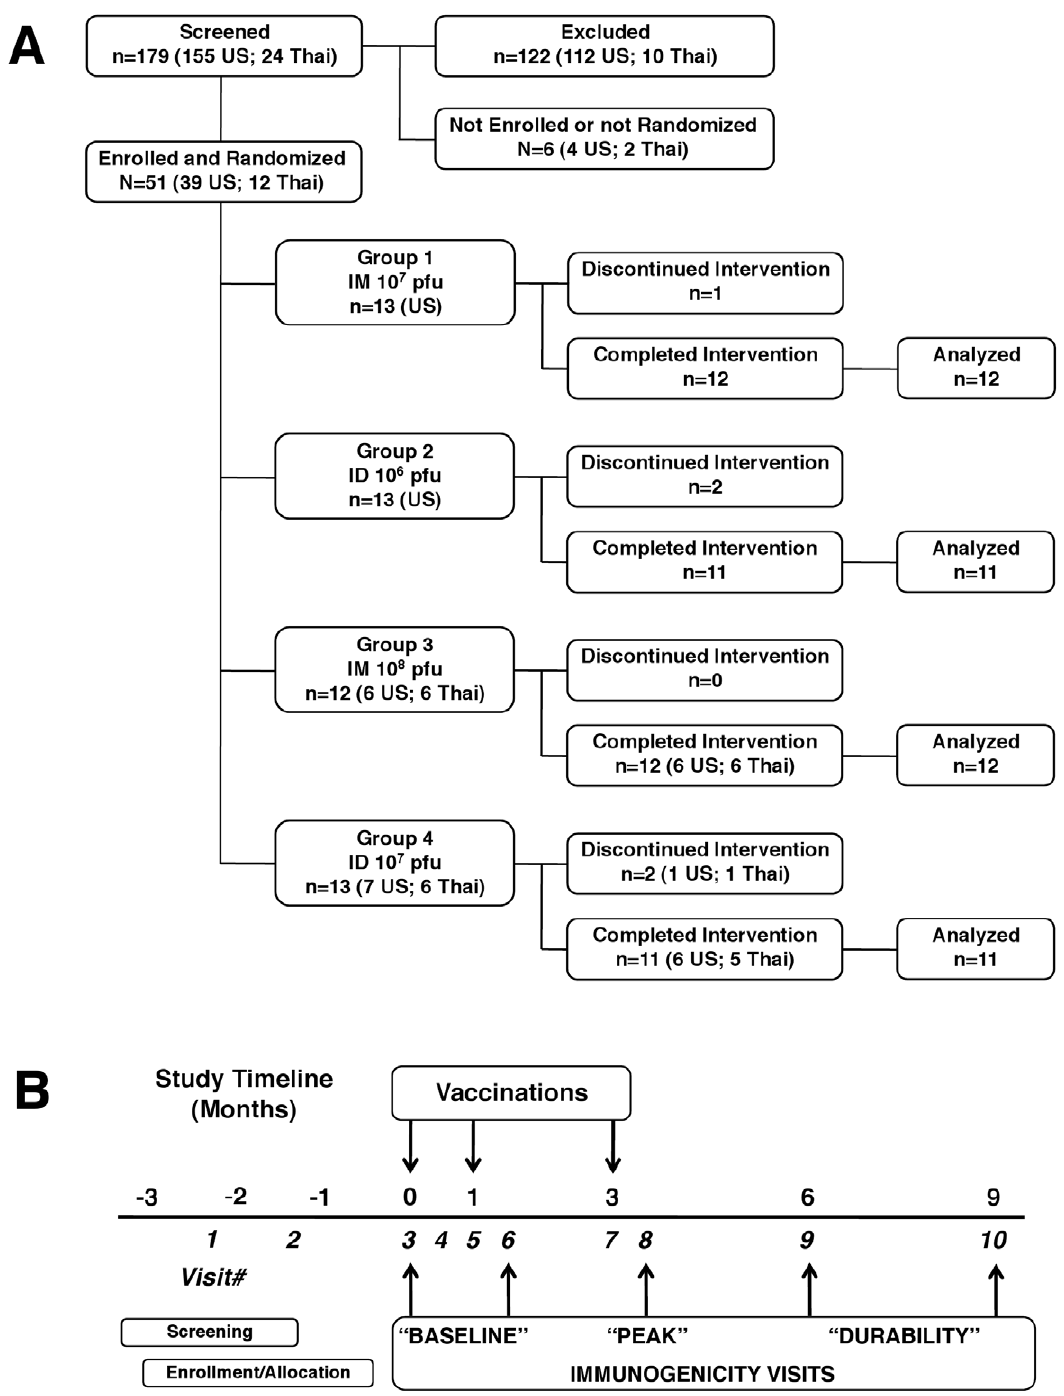
Figure 1. Consort clinical trial participant flow diagram (panel A). Chronological schematic diagram showing all pre-enrollment, vaccination and blood collection visits for RV158 (panel B). Immunogenicity testing visits 3, 6, 8, 9 and 10 correspond to days 0, 42, 98, 168 and 252 post- vaccination initiation respectively.